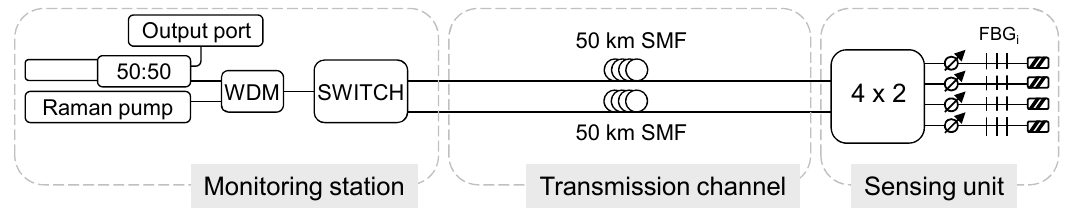
Figure 5. Experimental set-up for the multiwavelength Raman fiber laser for long distance remote-sensing with self-healing beaviour. Adapted from [66].